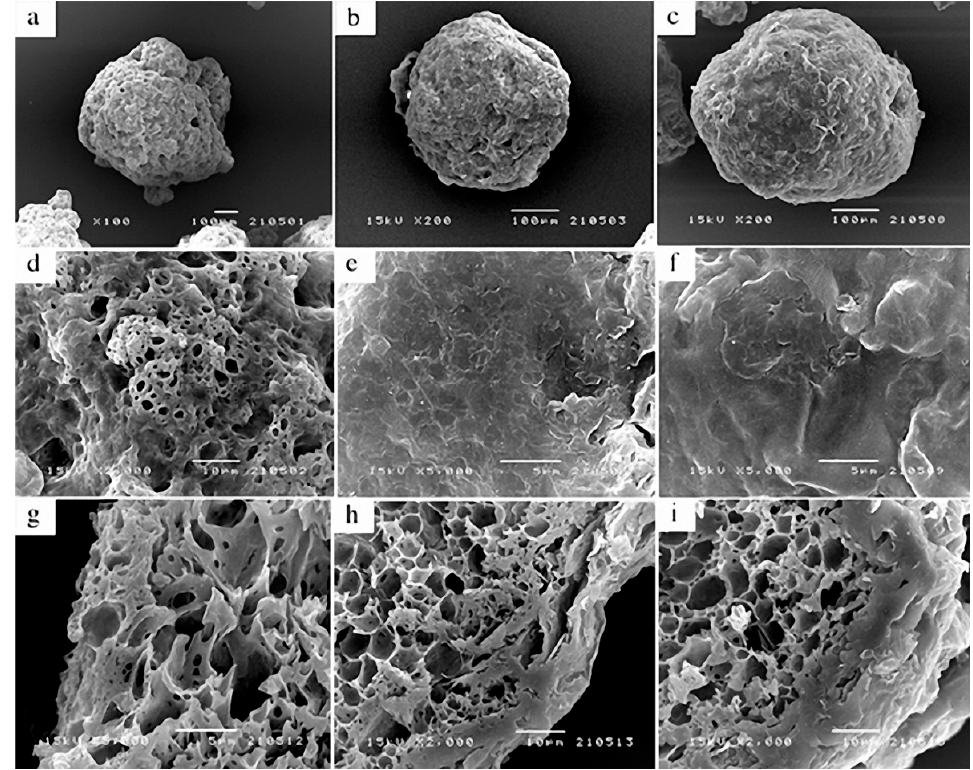
Figure 21. SEM micrographs of UC, CC, and CB gelatin ‐ based microcapsules: ( a ) whole UC; ( b ) whole CC; ( c ) whole CB; ( d ) external surface of UC; ( e ) external surface of CC; ( f ) external surface of CB; ( g ) inner edge of UC; ( h ) inner edge of CC; ( i ) inner edge of CB [204] .